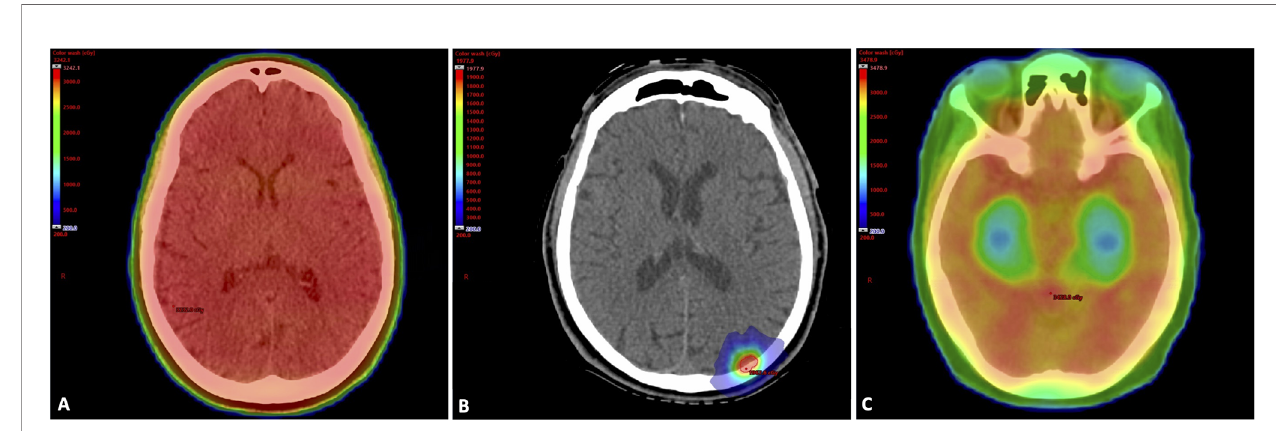
FIGURE 1 | (A) Whole Brain Radiation Therapy Treatment Plan. Treatment plan for a 65-year-old woman with metastatic non-small cell lung cancer. She had a large burden of intracranial disease and was treated with WBRT to a dose of 30 Gy in 10 fractions. In WBRT, the entire brain including areas that play a major role in neurocognition receive the prescription radiation dose. The patient received memantine during and after treatment based on dosing from RTOG 0614. (Gy, gray; RTOG, radiation therapy oncology group; WBRT, whole brain radiation therapy). (B) Stereotactic Radiosurgery Treatment Plan. Treatment plan overlaid on simulation CT scan for a 50-year-old man with a history of BRAF wild-type metastatic melanoma who developed a left occipital lobe metastasis. He was treated with single fraction SRS to a dose of 20 Gy. (Gy, gray; SRS, stereotactic radiosurgery). (C) Whole Brain Radiation Therapy with Hippocampal Avoidance Treatment Plan. Treatment plan for a 60-year-old woman with metastatic breast cancer who was treated with HA-WBRT and memantine to 30 Gy in 10 fractions. Areas in red received the prescription dose, while areas in green and blue represent lower dose areas. Note the sparing of the bilateral hippocampi. (Gy, gray; HA-WBRT, hippocampal avoidance whole brain radiation